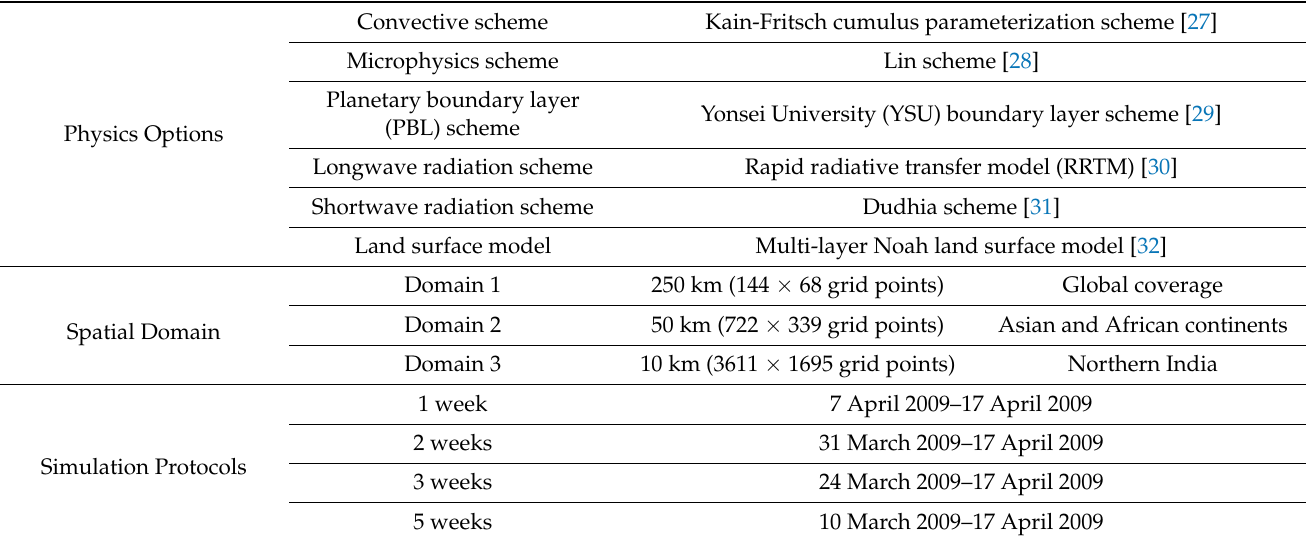
Figure 2. Spatial map showing distribution of ( a ) Rainfall (mm); ( b ) Temperature ( ◦ C) averaged across the years 2001–2013 for the crop (rabi-wheat) season (November–April). (Source: IMD). Table 1. Regional climate model setup